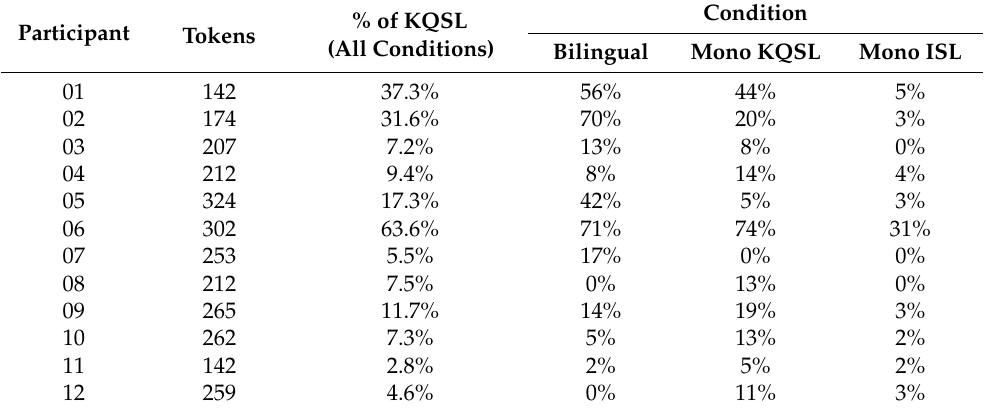
Table 5. Individual variation of